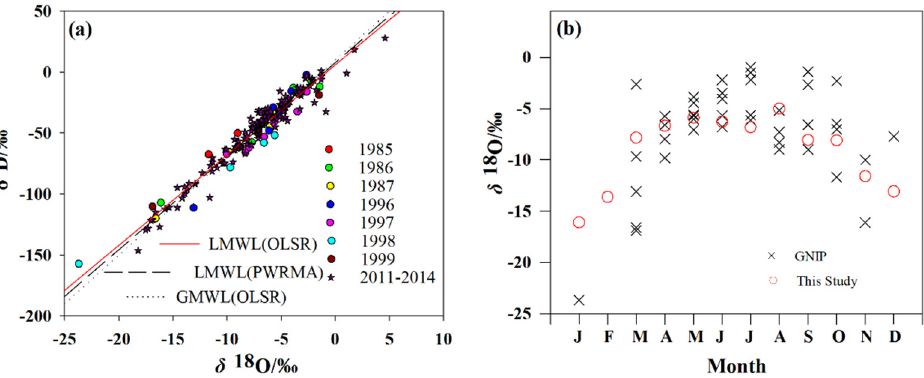
Figure 10. The figure ( a ) shows OLSR-based and PWRMA-based LMWLs in the Lanzhou city from 1985 to 1987, 1996 to 1999, 2011 to 2014 ( n = 179). The monthly isotopic data during 1985–1987 and 1996-1999 was provided by IAEA/WMO (2017), and the event-based data during 2011–2014 were precipitation-weighted to monthly series. The figure ( b ) shows monthly variation of δ 18 O in precipitation in the Lanzhou city (GNIP dataset: 16 months during 1985–1987 and 25 months during 1996–1999) and the in situ observations in this study.